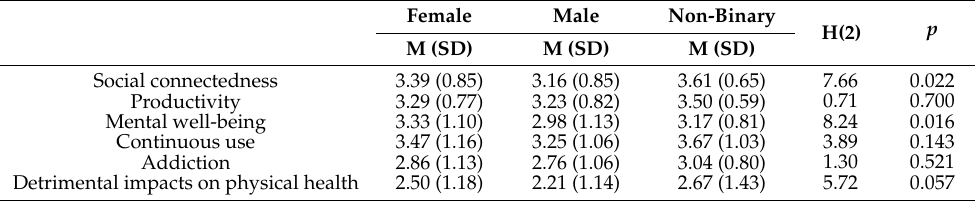
Table A5. Mobile Device Affinity and Usage since March 2020 Based on Gender.